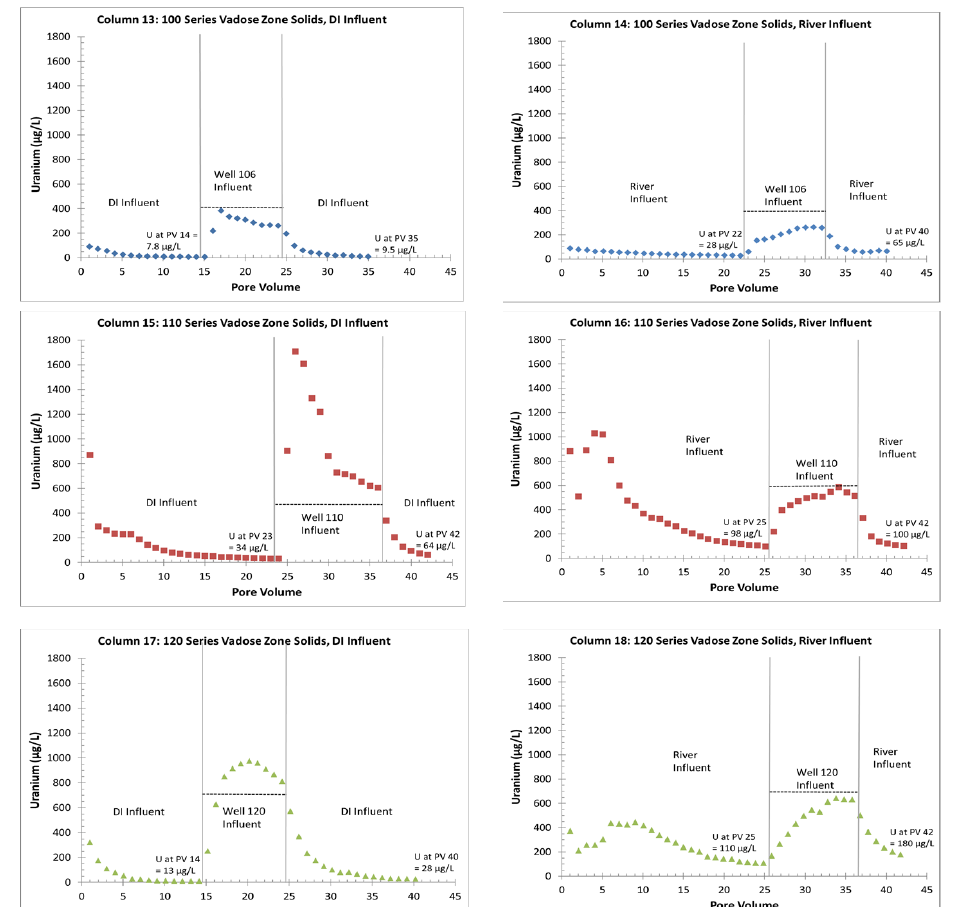
Figure 4. Effluent uranium concentrations for columns with VZ solids and DI or Gunnison River influents. Vertical lines indicate influent switches to underlying groundwater and dashed horizontal lines indicate influent groundwater uranium concentrations. Uranium in DI and Gunnison River water was 3 µg/L or less.